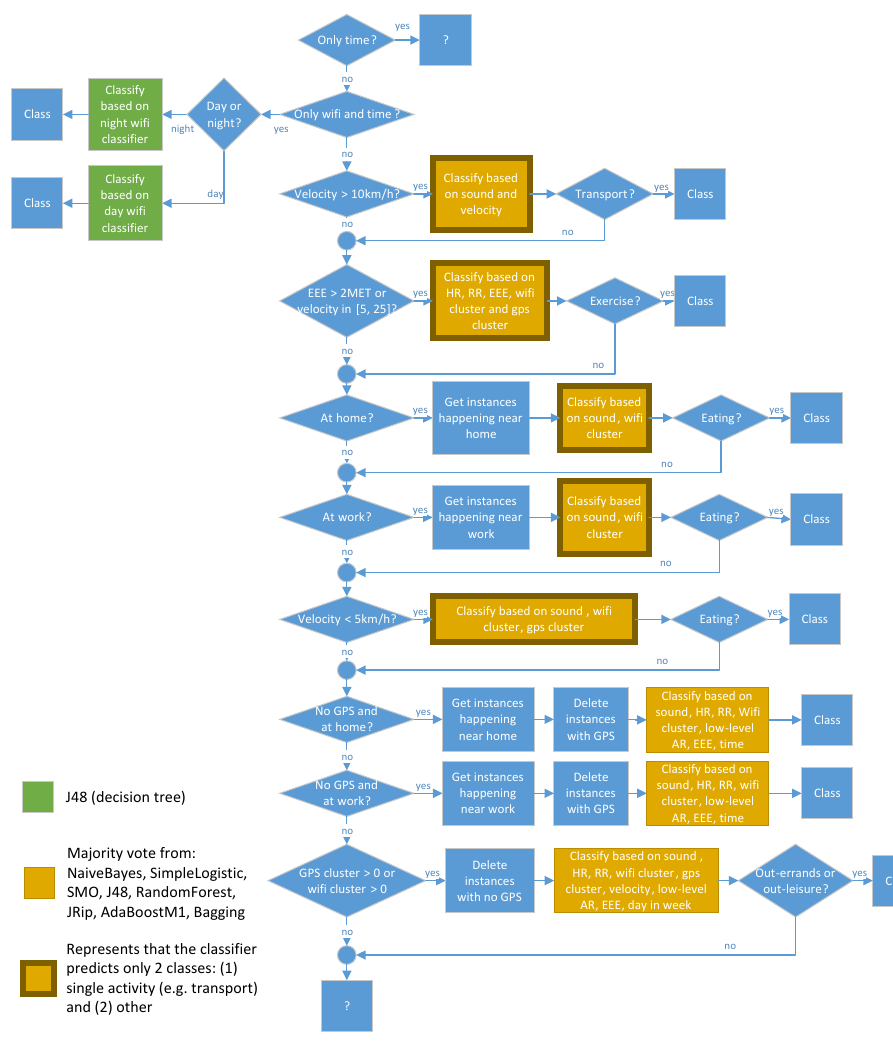
Fig. 1: The procedure for recognizing lifestyle activities using machine